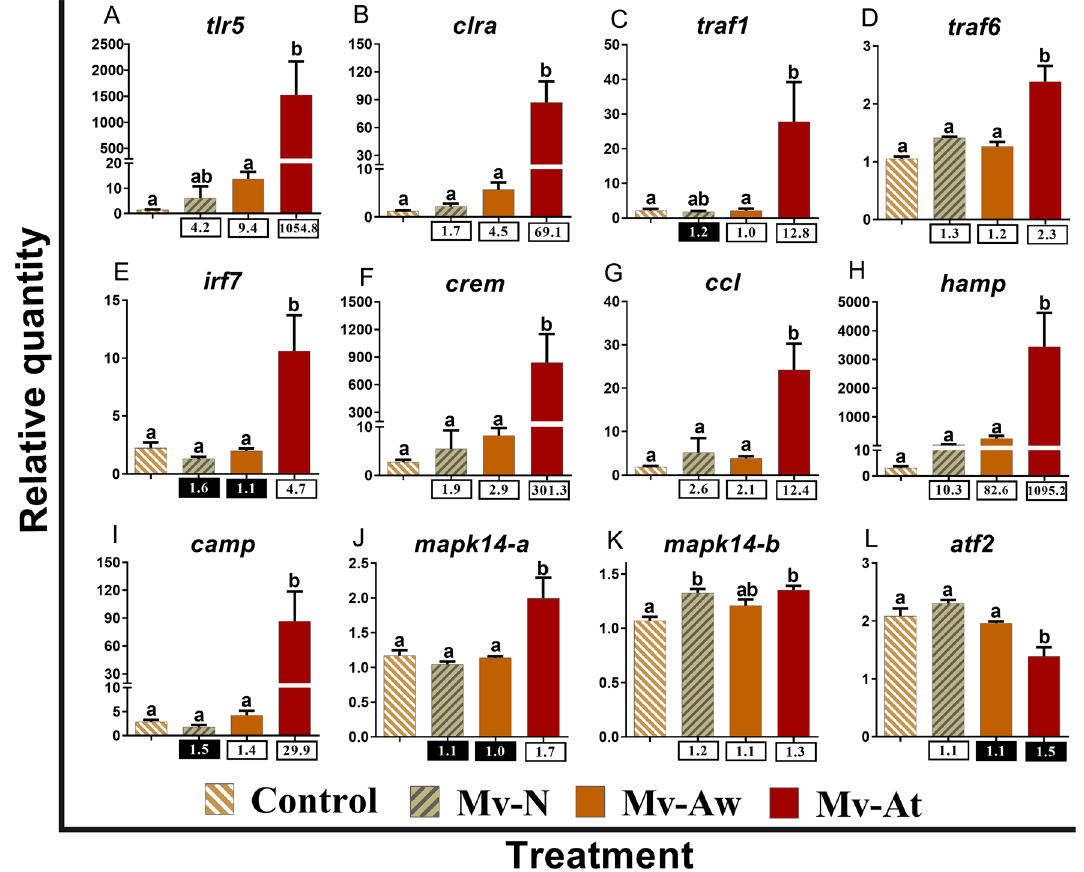
Figure 3. qPCR for M. viscosa -responsive transcripts playing putative roles in innate immune and antibacterial responses. The skin samples of M. viscosa -infected Atlantic salmon at the lesion (Mv-At; n = 4) and away (Mv- Aw; n = 4) sites, as well as the samples of fish with no lesion in M. viscosa group (Mv-N; n = 3) and non-infected control group (Control; n = 4), were used for qPCR validation. Data are presented as mean ± SE, with the lowest expressing sample as calibrator [i.e. set to relative quantity (RQ) 1.0]. Letters in each panel indicate significant differences between groups, as determined by one-way ANOVA with Tukey’s post hoc test ( p < 0.05). Fold- changes are shown below the groups, calculated as mean RQ of the group/mean RQ of the control. Black boxes indicate the down-regulated or negative fold-changes, which were calculated as 1/fold-change for comparisons that yielded fold-change values less than 1. Gene symbols are shown at the top of each panel ( A – L